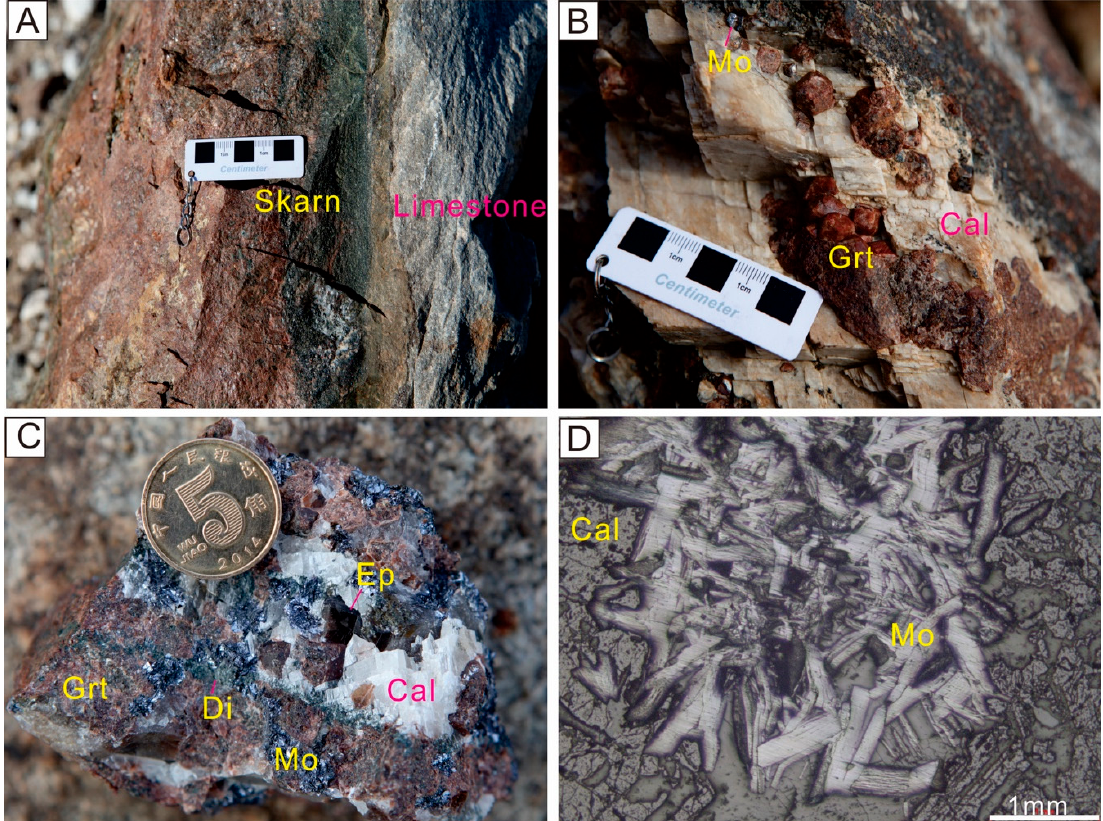
Figure 3. Field and thin section photos of the Lyangar W-Mo deposit. ( A ) skarn in the contacts to limestone; ( B ) coarse-grained, euhedral-subhedral garnet; ( C ) coarse-grained epidote and molybdenite aggregates; and ( D ) molybdenite displaying flakes or films texture. Abbreviations: Cal = calcite; Mo = molybdenite; Grt = garnet; Di = Diopside; Ep = epidote.